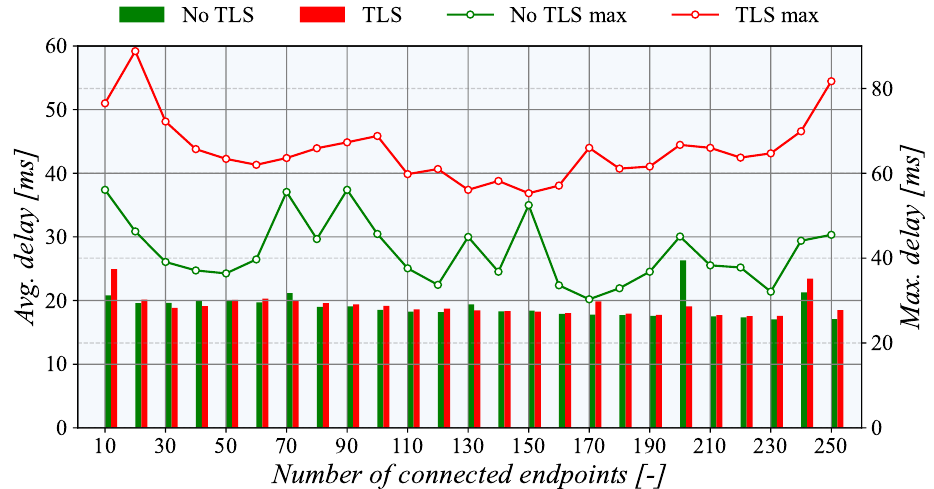
Figure 10. Communication delay during performed PUSH test